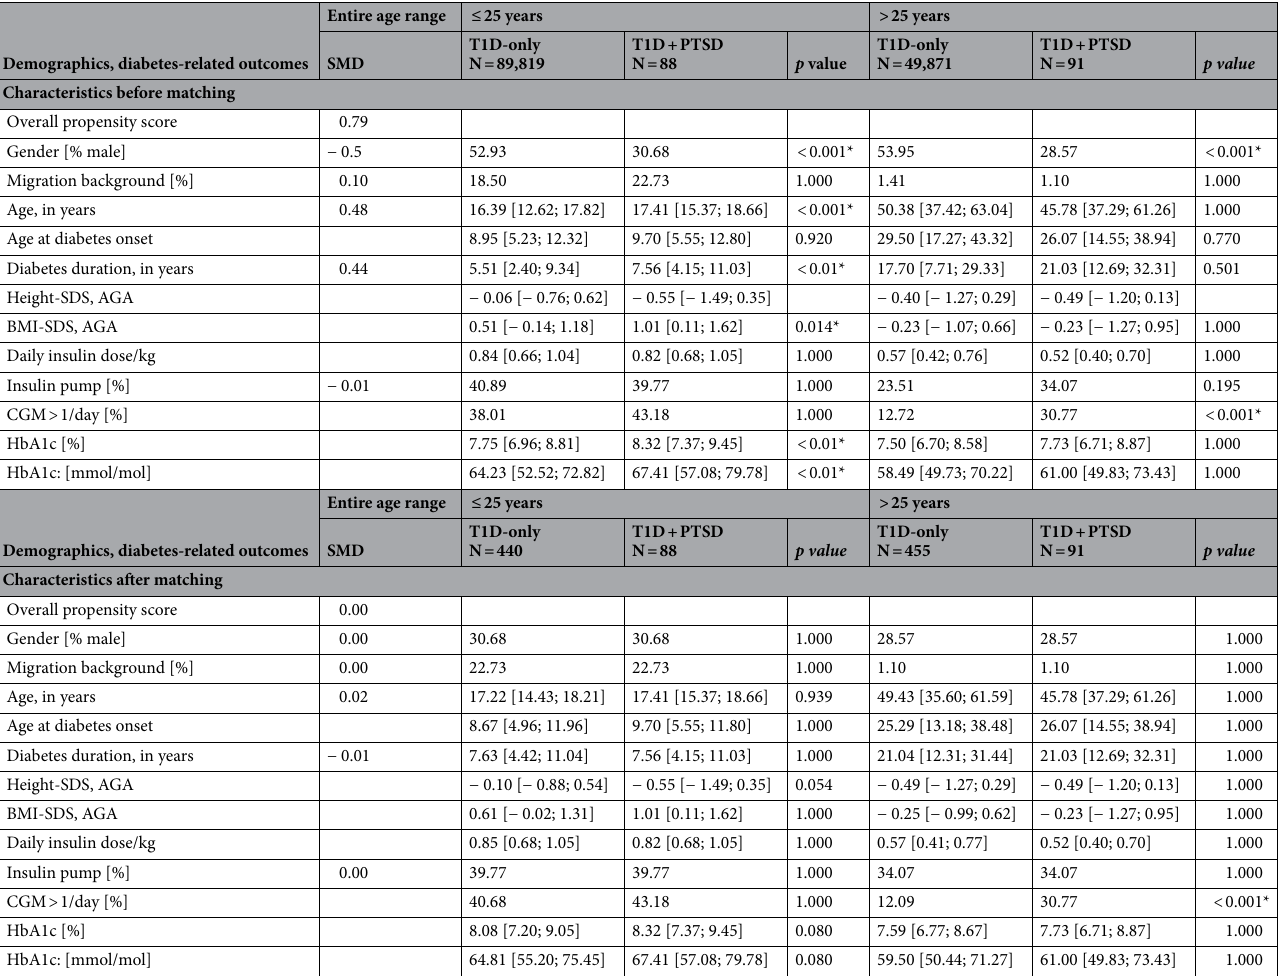
Table 3. Baseline characteristics of patients with T1D (for age ≤ 25, > 25 years) before and after matching (variables: age, gender, diabetes duration, type of insulin treatment and migration background), comparing patients with T1D and comorbid PTSD to patients with T1D and no comorbid mental disorder. All data are presented in median [Q1; Q3] or percentage [%]. Entire age range = Total age range of patients in the T1D + PTSD group and T1D-only group. SMD standardized mean difference between T1D-only group and T1D + PTSD group, T1D type 1 diabetes, PTSD posttraumatic stress disorder, T1D-only patients with T1D without comorbid mental disorder, T1D + PTSD patients with T1D and PTSD, with or without other mental disorder, BMI body-mass index, SDS standard deviation score, AGA Arbeitsgemeinschaft Adipositas im Kindes- und Jugendalter, CGM continuous glucose monitoring, HbA1c Hemoglobin A1c. *Significant (p <